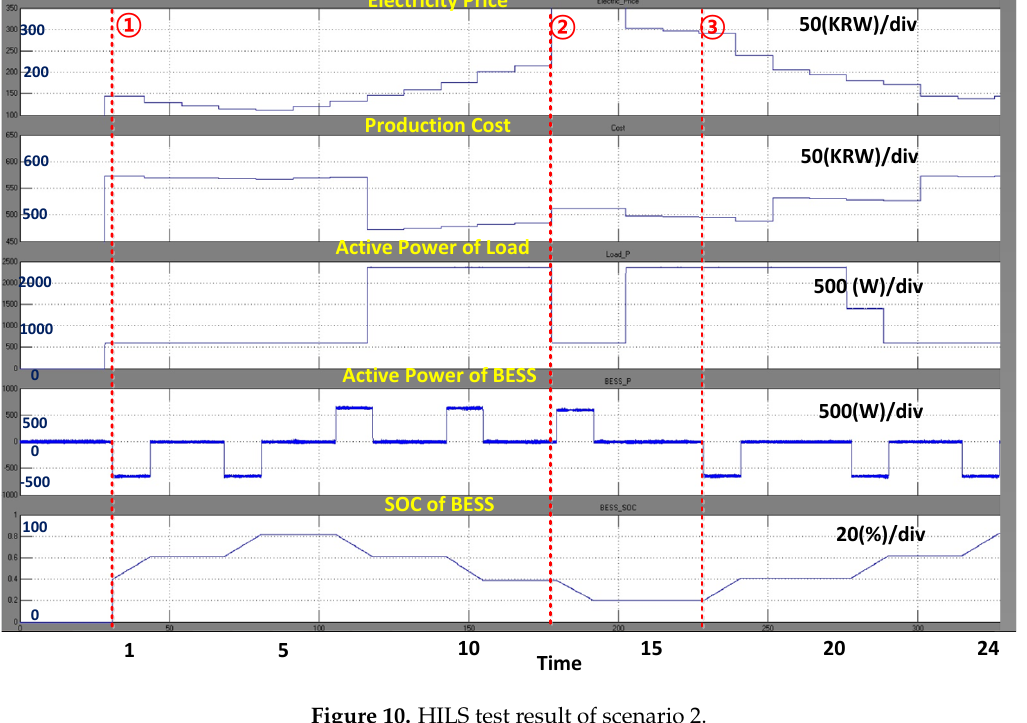
Figure 10. HILS test result of scenario 2.